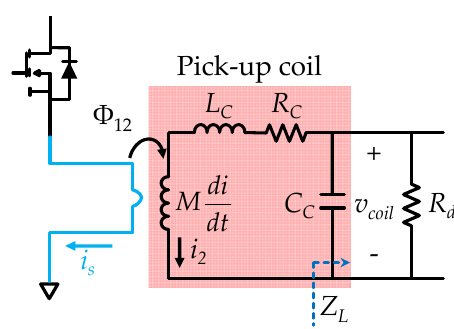
Figure 12. PCB-embedded pick-up coil equivalent circuit.